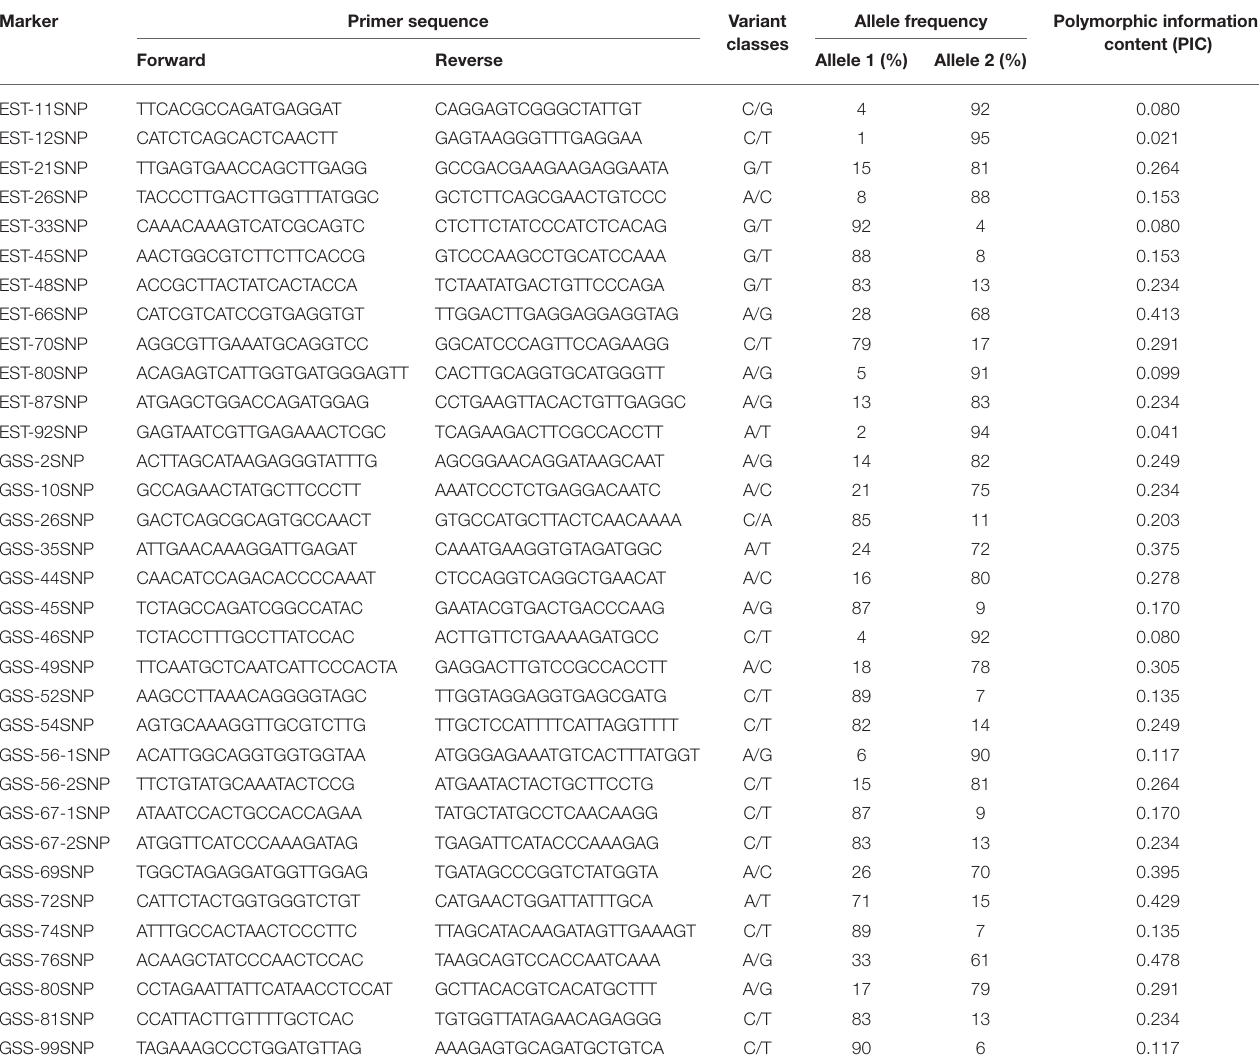
TABLE 1 | Allele frequencies and PIC values of SNP markers in peanut.